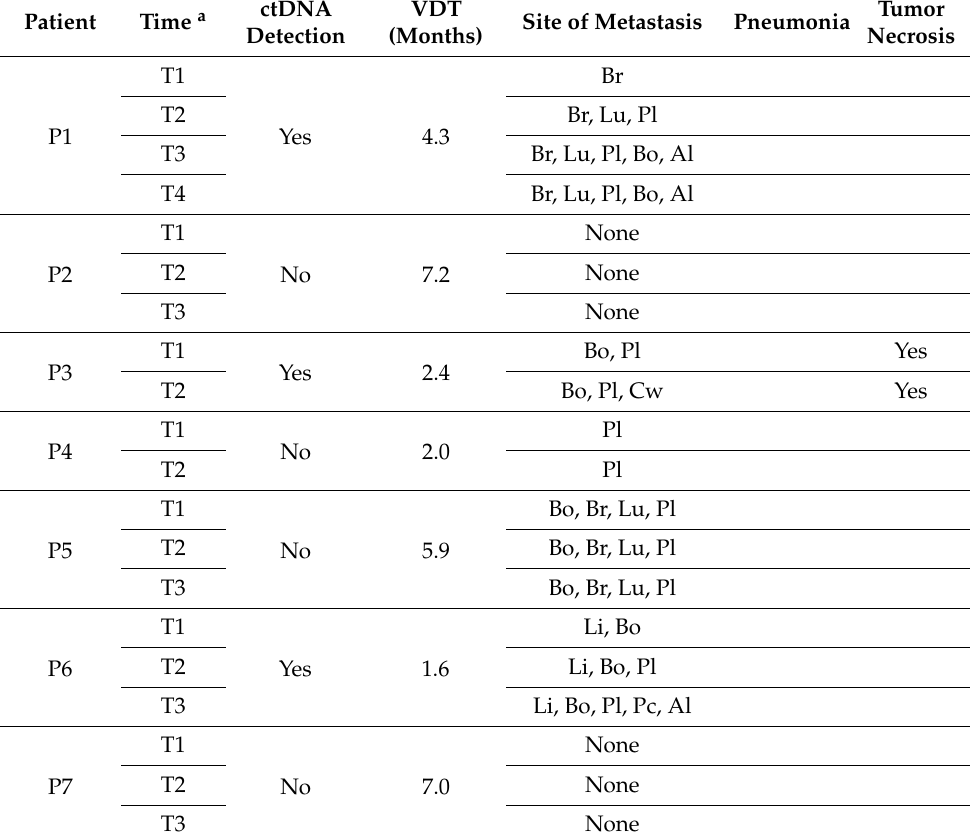
Table 1. Patient characteristics and circulating tumor DNA